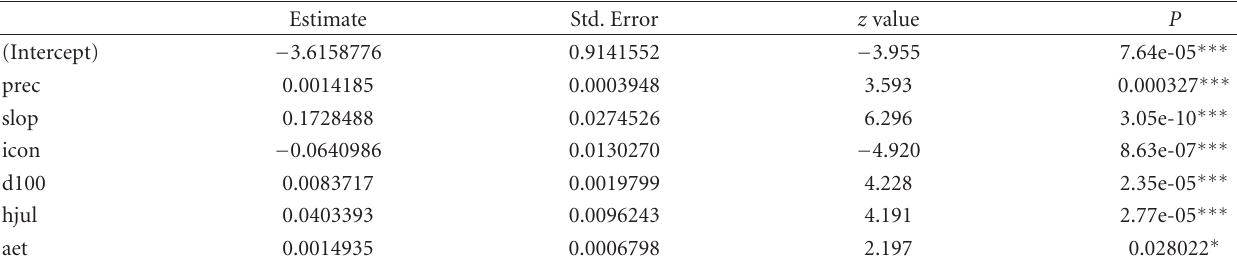
Table 7: B. bufo and not B. calamita .